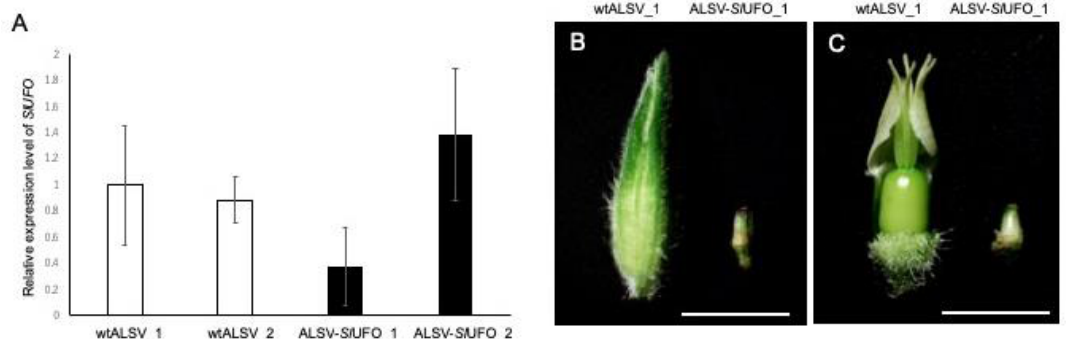
Figure 6. Relative expression level of the SlUFO gene and the exhibited phenotype in ALSV- Sl UFO plants. ( A ) RT-qPCR analysis of SlUFO gene expression levels in plants infected with wtALSV and ALSV- Sl UFO. A bud smaller than 2 mm was collected from different individual plants. Values represent means ± standard deviations of two technical replicates normalized to S. latifolia ubiquitin 11 gene; ( B ) a representative phenotype observed in a bud infected with wtALSV ( left ) and ALSV- Sl UFO ( right ). The buds shown here are derived from the same plants used for the RT-qPCR in ( A ). The bud size of the ALSV- Sl UFO-infected plant is relatively small, compared with that of the wtALSV-infected plant; ( C ) pictures taken after removal of the sepals from ( B ). Despite their small size, all floral organs appear normal. Bars = 1 cm.